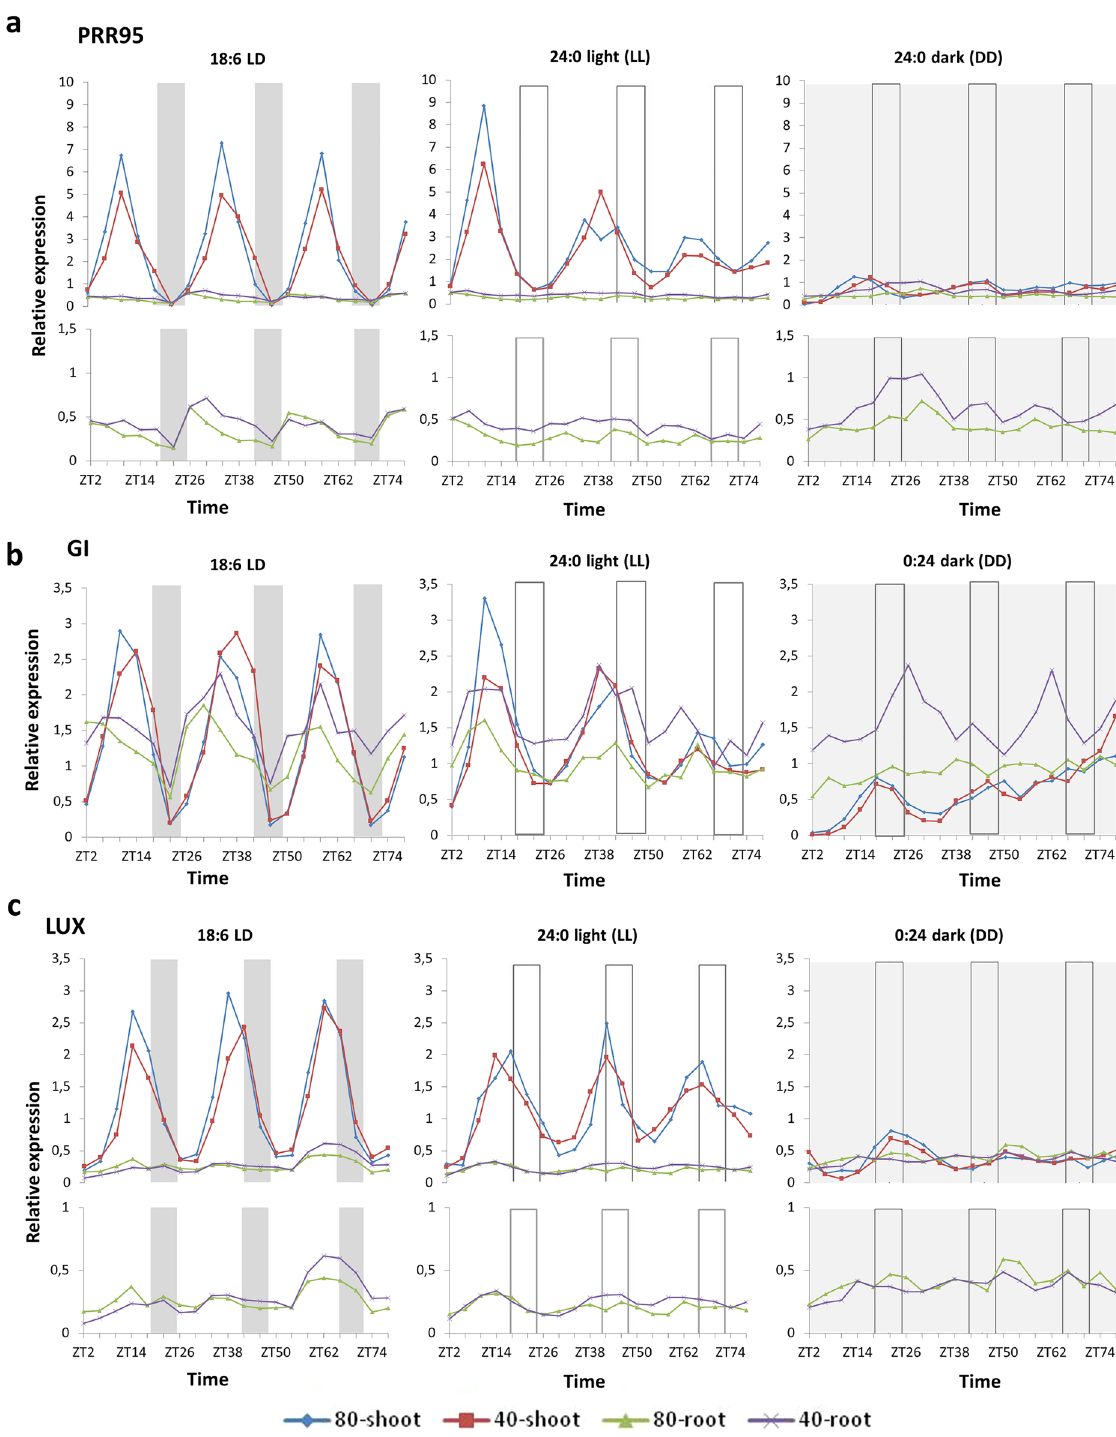
Figure 2. Time scale expression of Brachypodium distachyon PRR95, GI and LUX genes. Gene expression of BdPRR95 ( a ), BdGI ( b ) and BdLUX ( c ) was monitored by qRT-PCR over 76 h in total aerial parts (shoot) and total roots (root) of Brachypodium distachyon under two watering conditions [80% soil water content (80) and 40% soil water content (40)] and three lighting regimes (18:6 light:dark, 24:0 light and 0:24 dark). Plants were entrained for 4 weeks in 18:6 light:dark cycles (light period: 6:00 to 24:00; dark period: 24:00 to 6:00) before being exposed to the three different lighting regimes. As regards water status, plants were grown with 80% soil water content for two weeks before being subjected to modest water deprivation (40% soil water content) for two weeks before sampling. Bars represent the periods of night (grey bars) and subjective night (empty bars). Expression levels shown are relative to the average expression of two reference genes ( BdUBC18 and BdElFα ) and relative to mean expression level of the target gene over the 76 h in shoots grown under 18:6 light:dark cycles with 80% soil water content. Data shown are from two representative experiments. The related period, phase, amplitude and relative amplitude error dataset can be found in Table 2. Standard deviation and related expression dataset from the two experiments are shown in Supplementary File